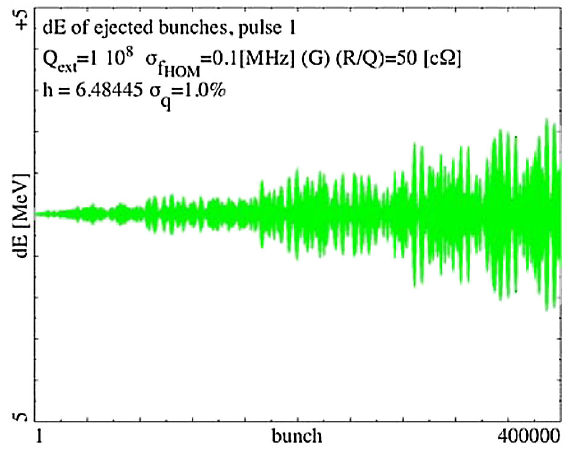
FIG. 59. (Color) dE at ejection [ (cid:3) 5 MeV ] of bunches 1 to 400 000, pulse 1. The envelope starts with zero amplitude and increases with bunch number